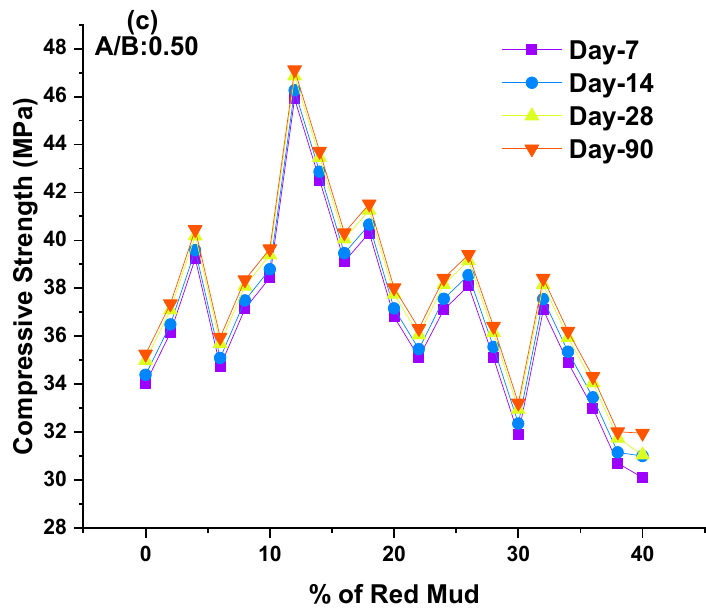
Figure 6. ( a – c ) These represent the CS results for 7, 14, 28, and 90 days for A/B ratio of 0.3, 0.4, and 0.5 for various mixes of GPC, respectively.